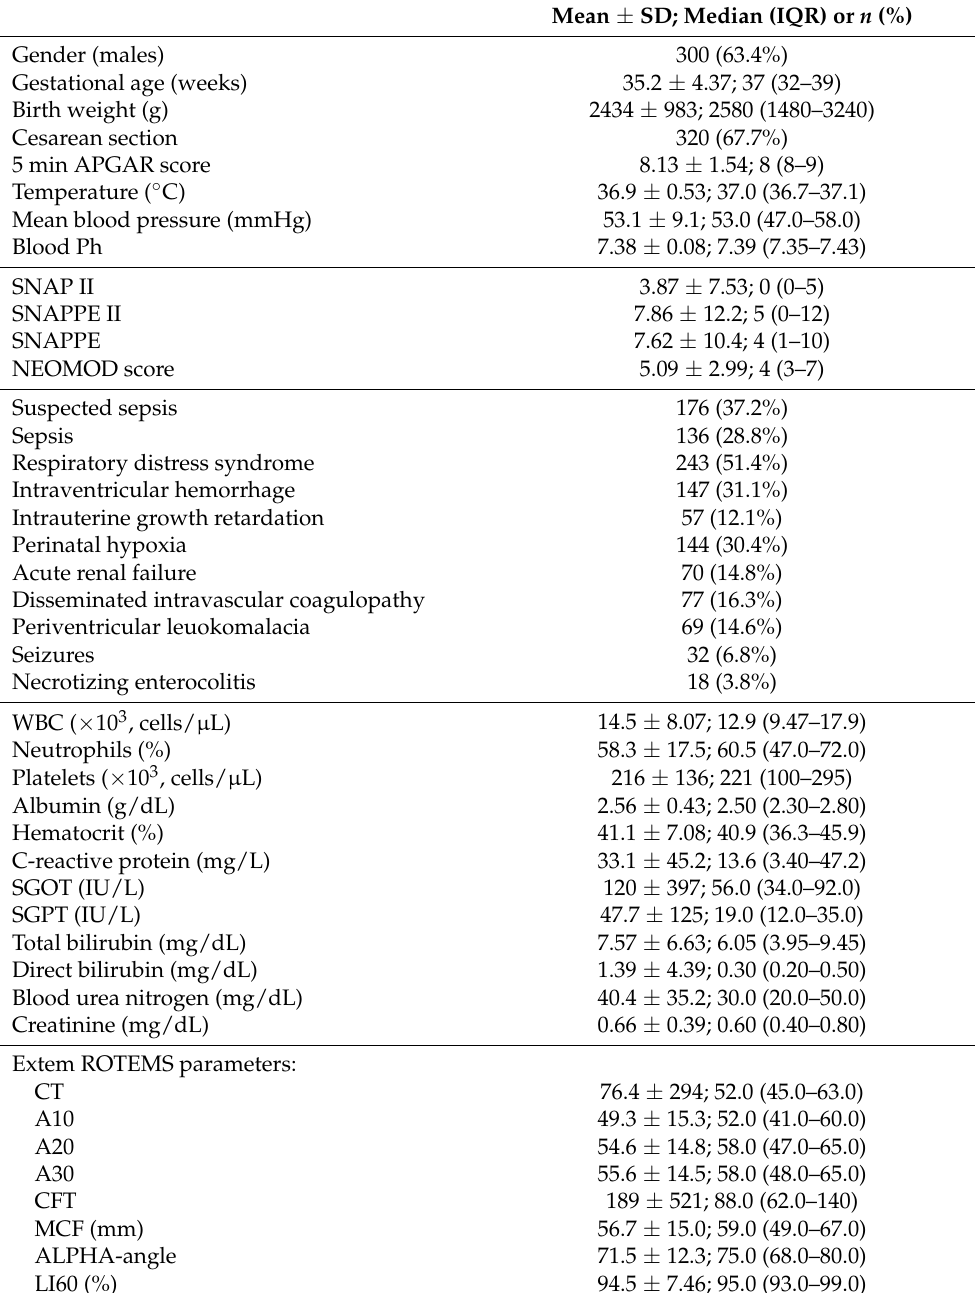
Table 1. Characteristics of the study population ( n =